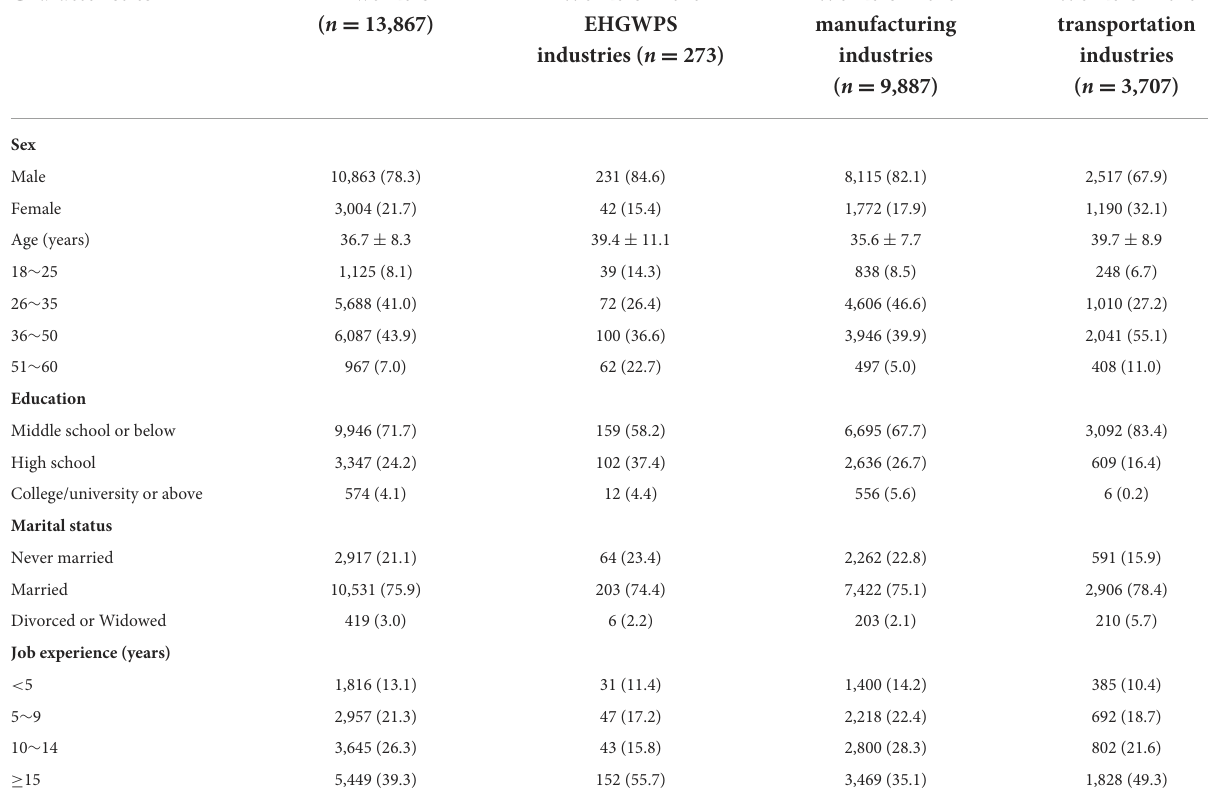
TABLE 1 Workers’ demographic characteristics ( n = 13, 867). Characteristics All workers